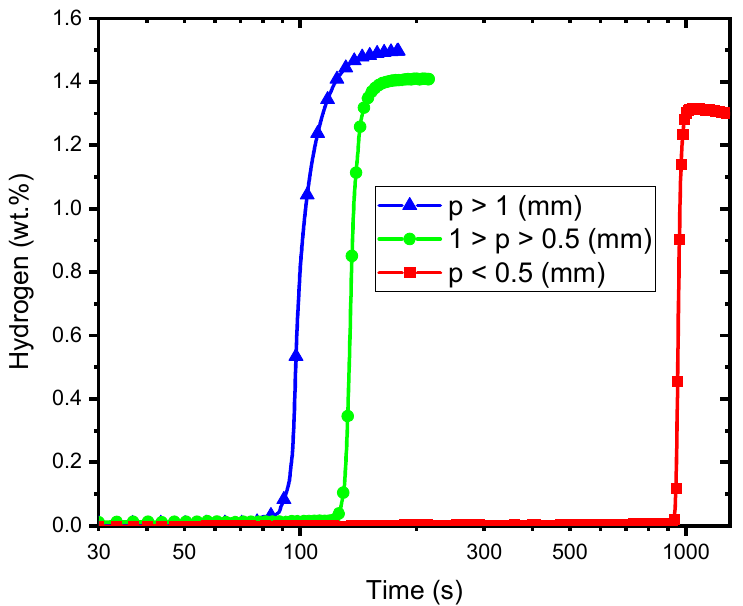
Figure 2. First hydrogenation at room temperature under 1500 kPa of hydrogen of LaNi 5 for different particle sizes.